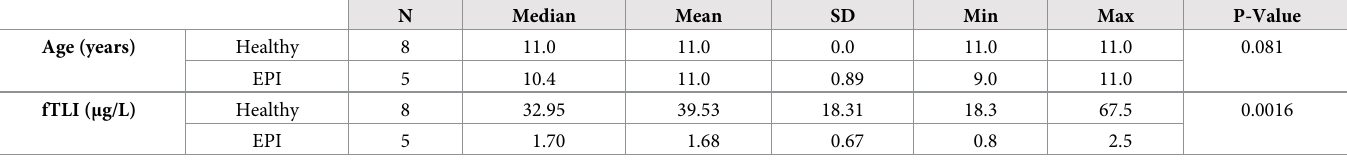
Table 1. Patient population